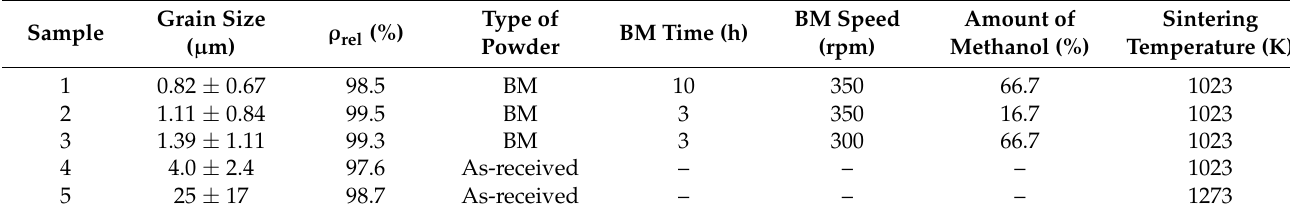
Table 1. Synthesis parameters of the samples (BM: ball milling).